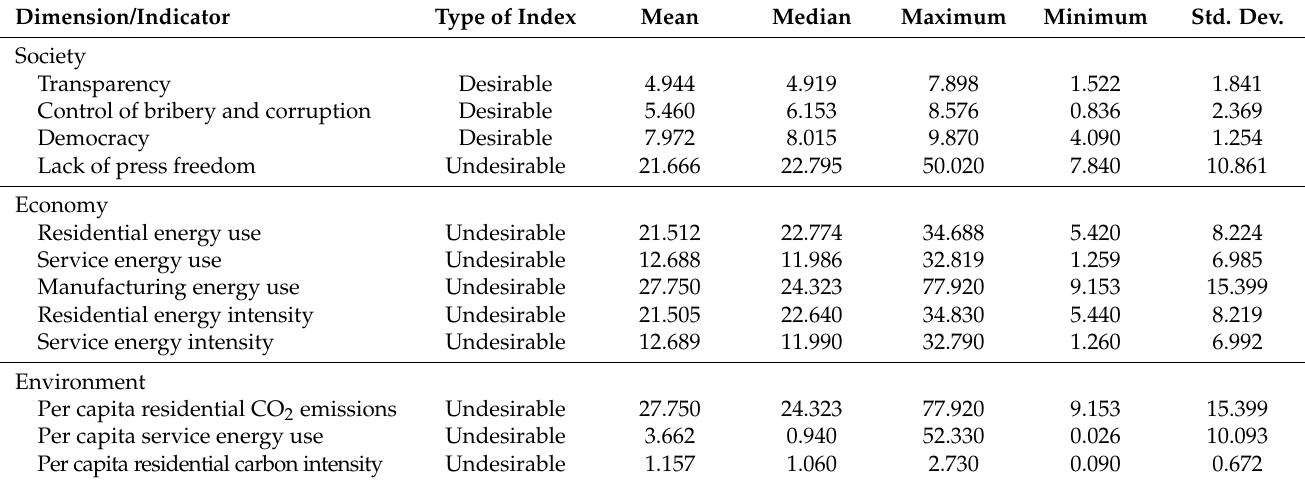
Table 2 contains descriptive data for the filtered twenty-six economies’ sub-dimensions. Table 2. Descriptive statistics of sub-dimension